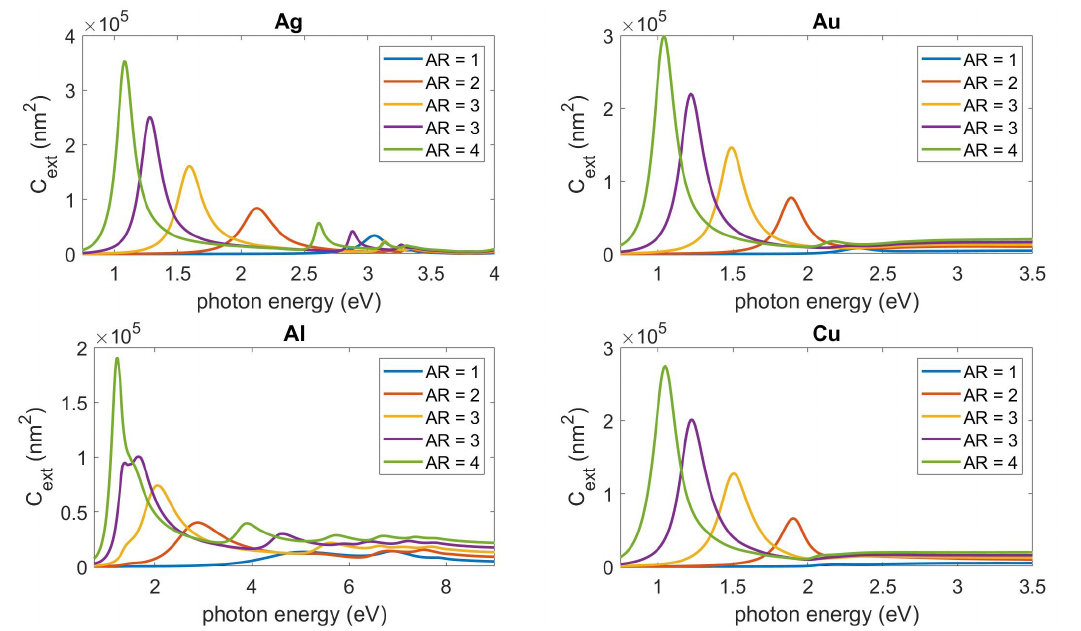
Figure 6. Extinction efficiency for Ag, Au, Al and Cu nanorods with varying aspect ratio ( AR ) and constant hemispherical cap radius ( a = 25 nm) embedded in water ( (cid:101) h =